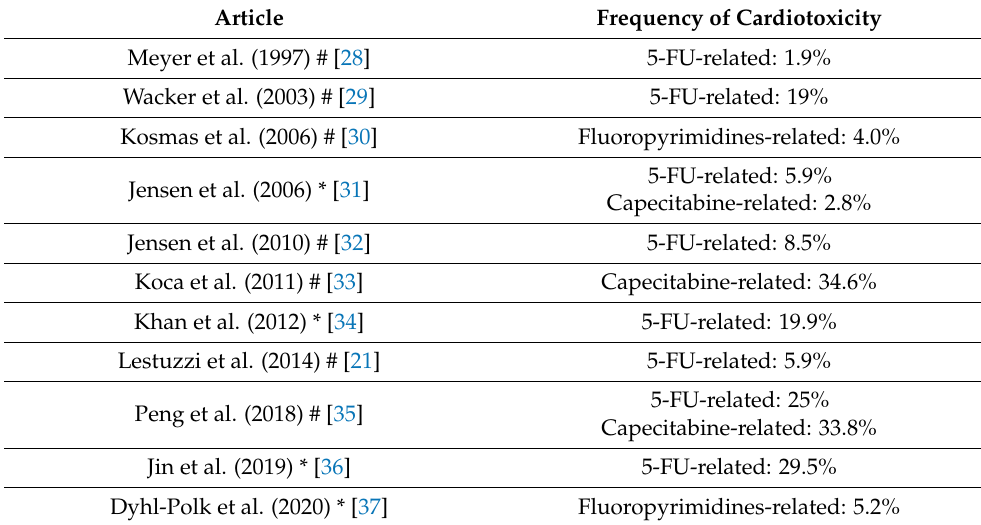
Table 1. Frequency of cardiotoxicity after the administration of fluoropyrimidines. *—retrospective study; #—prospective